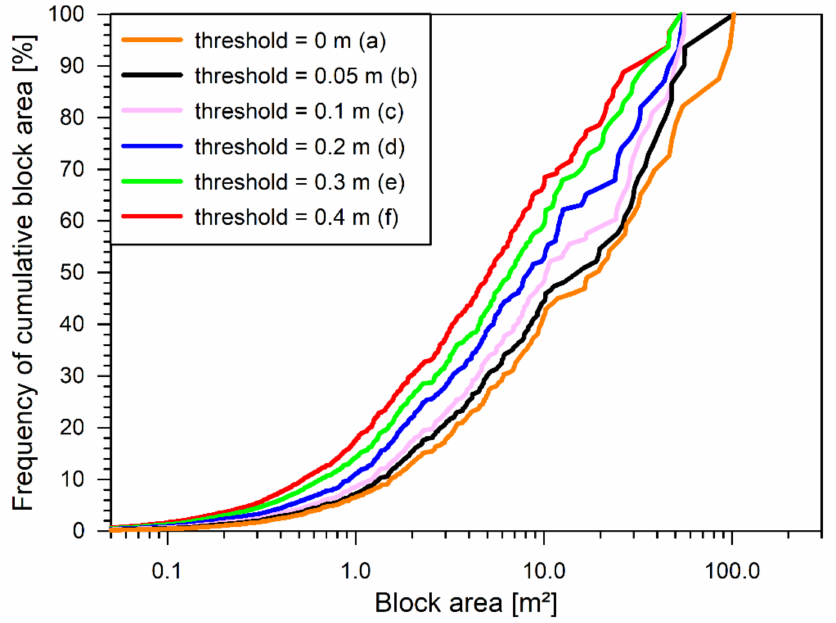
Figure 7. Cumulative block area distribution of the six simulation examples presented in Figure 6.